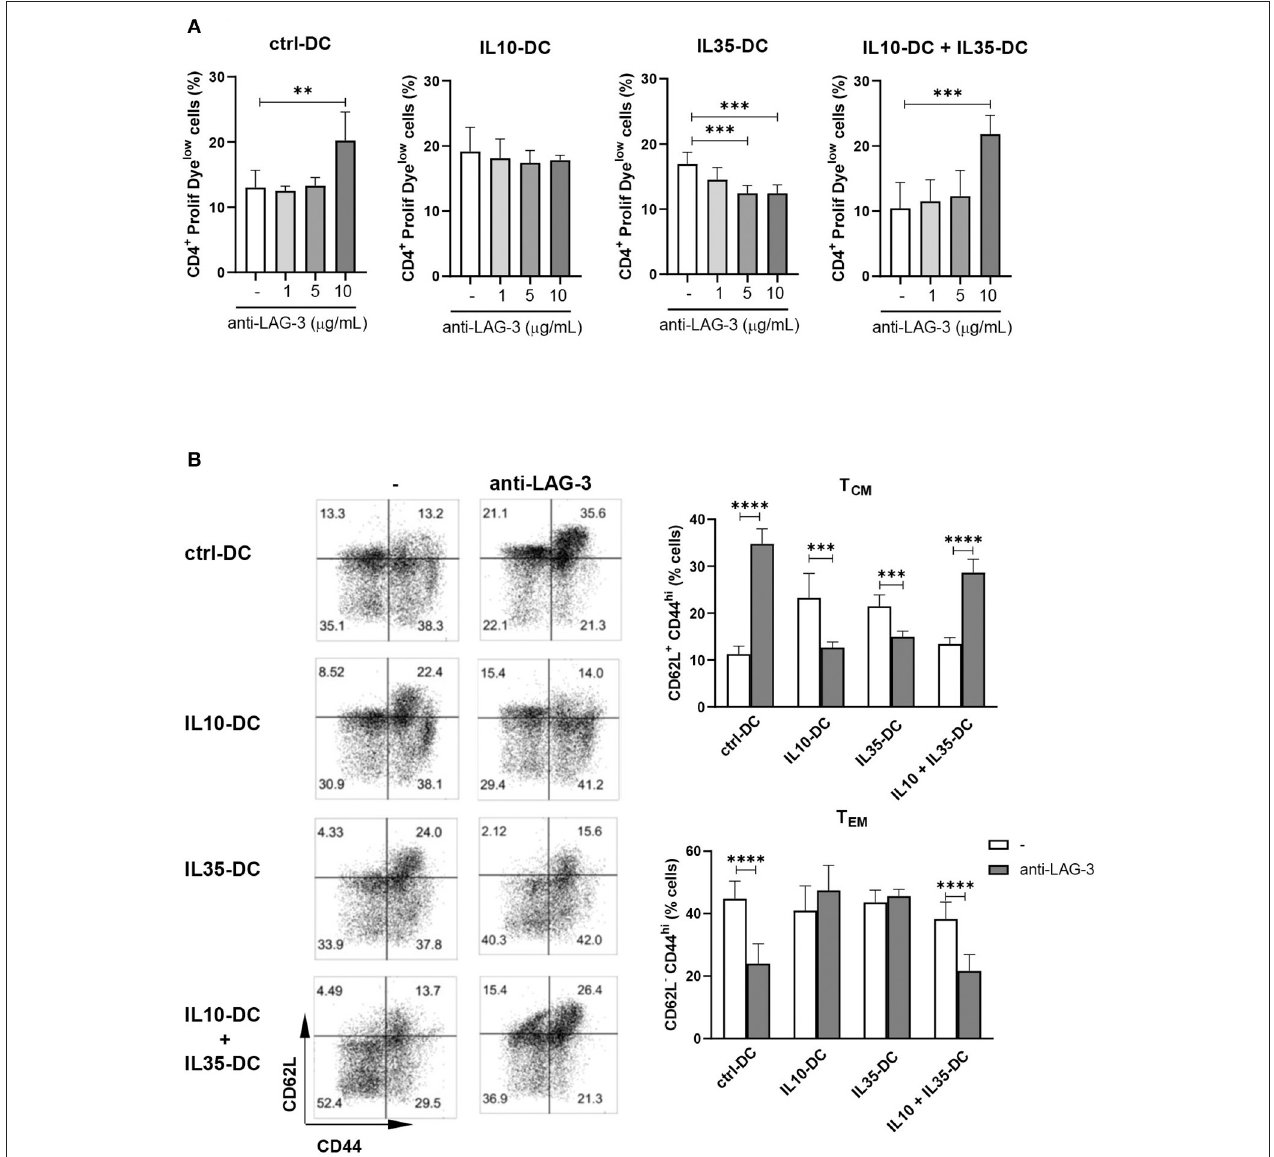
FIGURE 6 | IL10-DCs in combination with IL35-DCs arrest memory expansion through LAG-3. CD4 + T cells were isolated from the spleens of OVA-immunized mice, labeled with a proliferation dye, and put in co-culture with OVA-pulsed DCs in the presence of anti-LAG-3 blocking antibody for 3 day. Flow cytometric analysis of (A) T cell proliferation after co-cultures and (B) CD4 + memory (CD62L + CD44 high ) or effector (CD62L − CD44 high ) cell population. Data are representative of at least two independent experiments with T cells isolated from five independently immunized mice ( n = 5, each experiment). ** P < 0.005, *** P < 0.001, **** P <